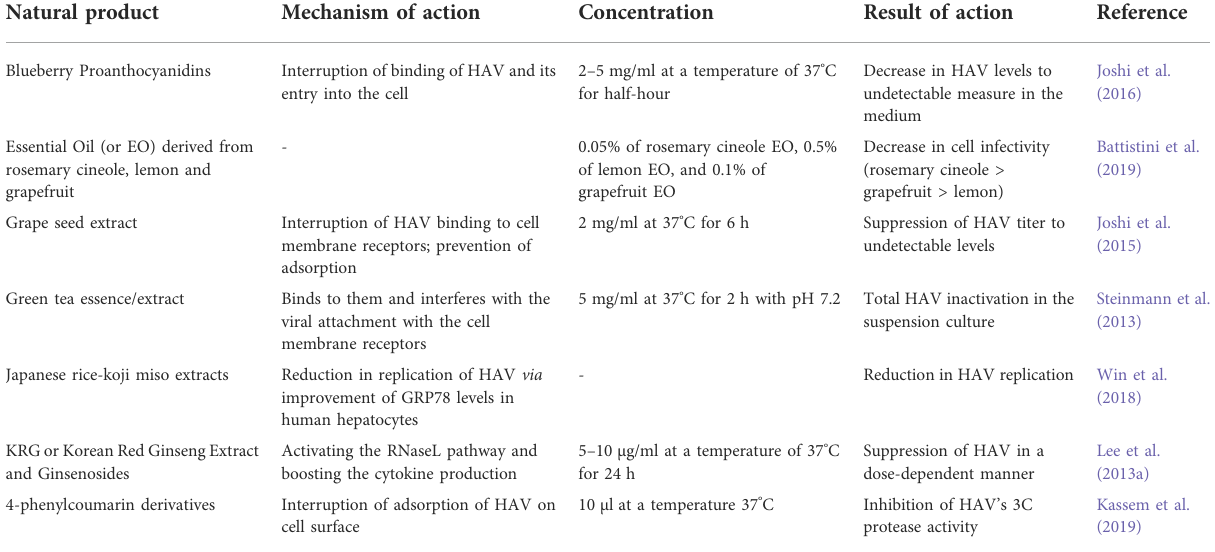
TABLE 1 Natural products for hepatitis A treatment.